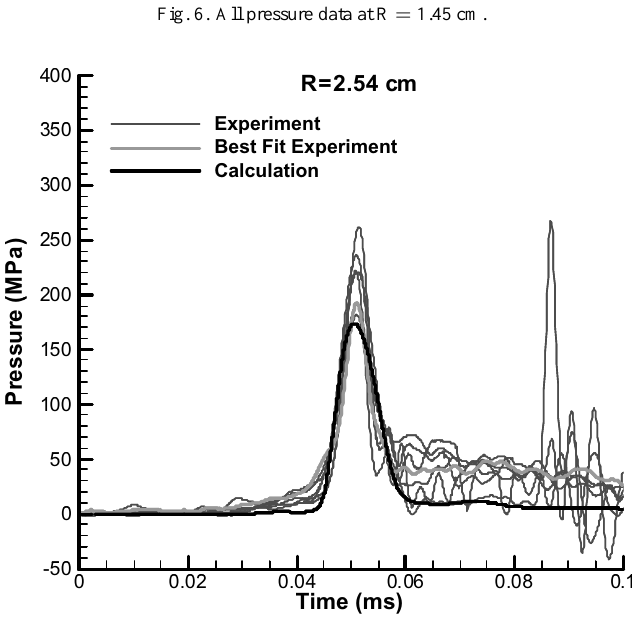
Fig. 6. All pressure data at R = 1.45 cm.